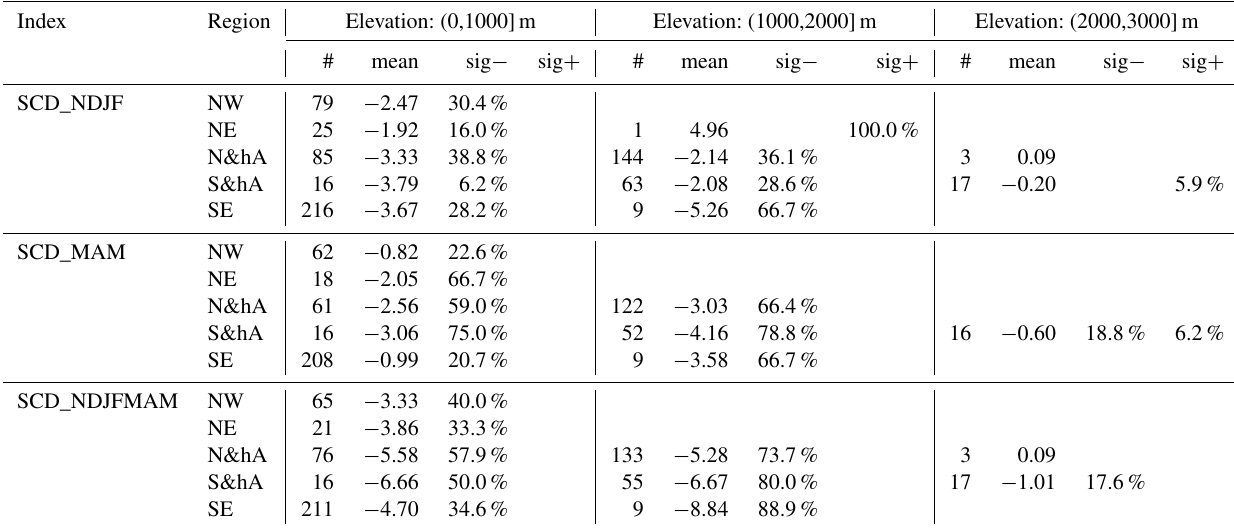
Table C2. Overview of long-term (1971 to 2019) trends in mean seasonal snow cover duration indices. Summaries are shown by index, region, and 1000m elevation bands (0 to 1000, 1000 to 2000, and 2000 to 3000m). Cell values are the number of stations (#), the mean trend (mean, in d per decade), and percentages of significant negative (sig − ) and positive (sig + ) trends; the remaining percentage (not shown) corresponds to the total of non-significant negative and positive trends. Empty cells denote no station available (for # and mean) and no stations with significant negative or positive trends (sig − and sig + ) . Trends were considered significant if p < 0.05. See also Fig. C2. A version of the table with 500m bands instead of 1000m is available in the Supplement (Table